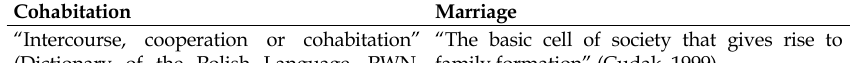
Table 1. Differences in de (cid:222) nitions of marriage and cohabitation